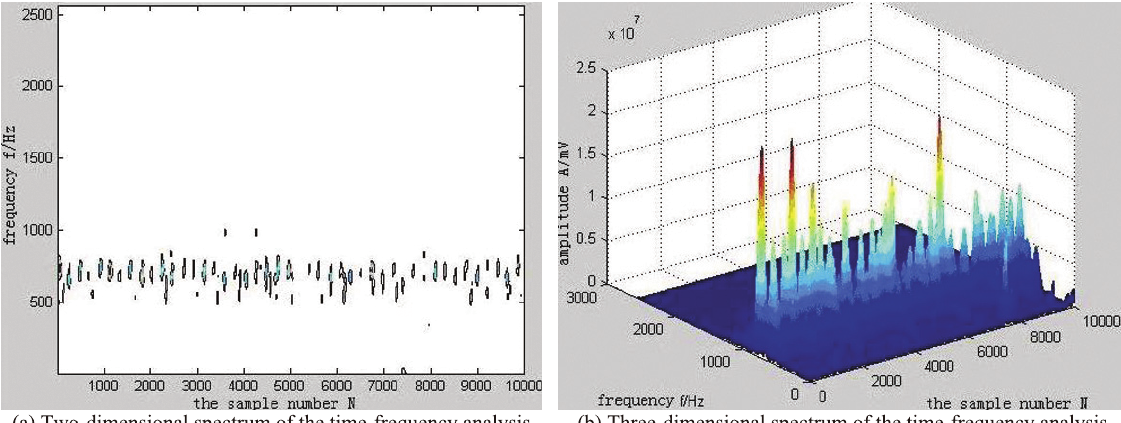
Fig. 9. The time frequency analysis of a no fault signal at 900 rpm.